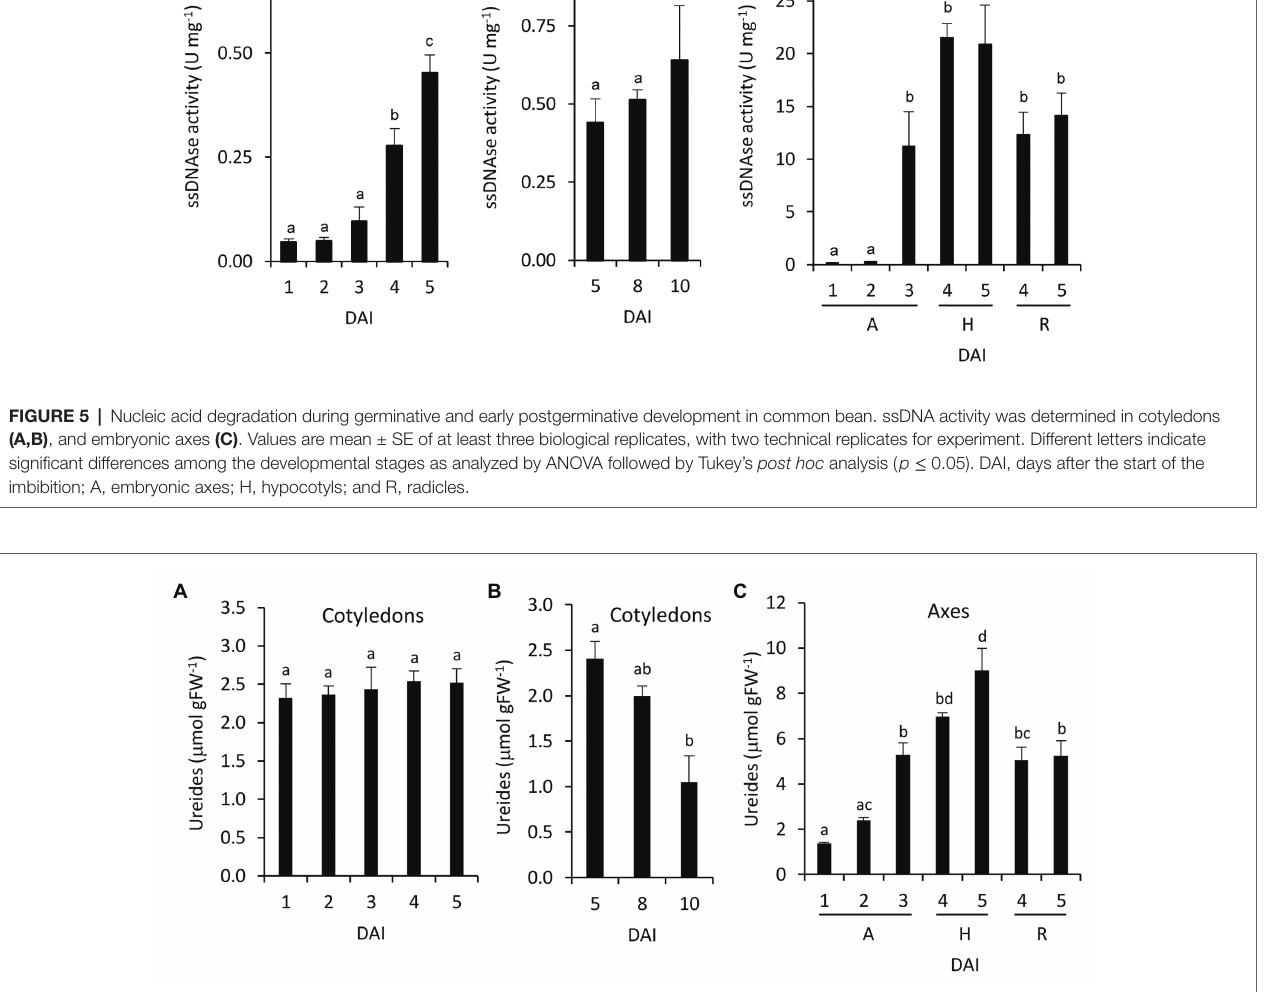
FIGURE 6 | Ureides accumulation during germinative and early postgerminative development in common bean. Ureides accumulation was determined in cotyledons (A,B) and embryonic axes (C) . Values are mean ± SE of at least three biological replicates. Different letters indicate significant differences among the developmental stages as analyzed by ANOVA followed by Tukey’s post hoc analysis ( p ≤ 0.05). DAI, days after the start of the imbibition; A, embryonic axes; H, hypocotyls; and R,